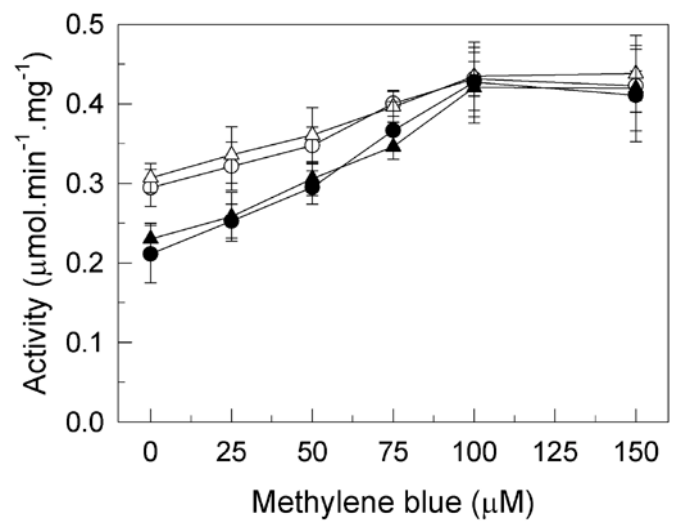
Figure 1. Effects of tau and/or methylene blue (MB) on Ca 2+ -ATPase activity in membranes from human control (HC, ) and Alzheimer’s disease (AD) affected (HAD, ) brain samples. Membranes (20 µg) were incubated as previously described without (open symbols) or with (filled symbols) 7.5 nM tau in 1 mL final volume with the assay medium, which also contained 0.01% saponin. Activities were assayed after triggering the reaction with 1 mM ATP followed by the addition of the indicated concentrations of MB. Data are expressed in µmol.min − 1 .mg − 1 protein ± SE of four experiments performed with four preparations. * p < 0.001 vs. control.